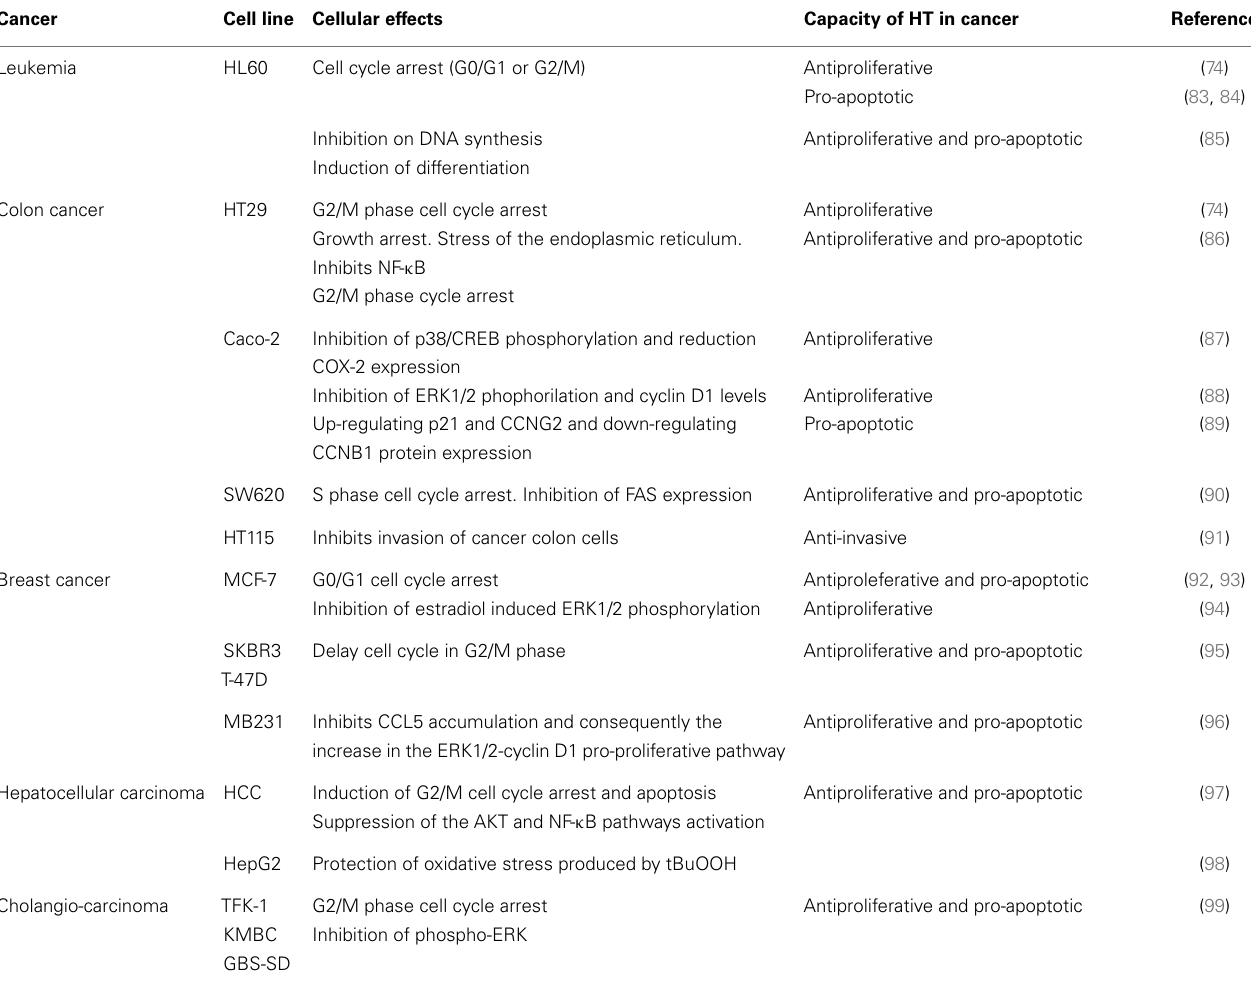
Table 2 | Chemo-preventive properties of hydroxytyrosol in studies of cancer cell lines